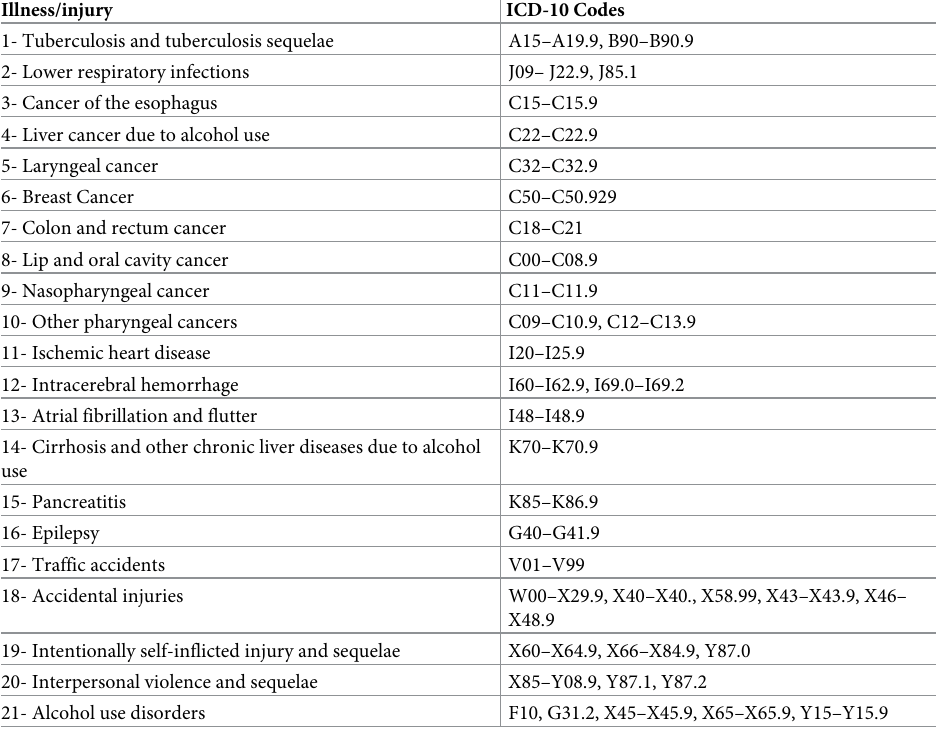
Table 1. Groups of diseases and conditions included in the